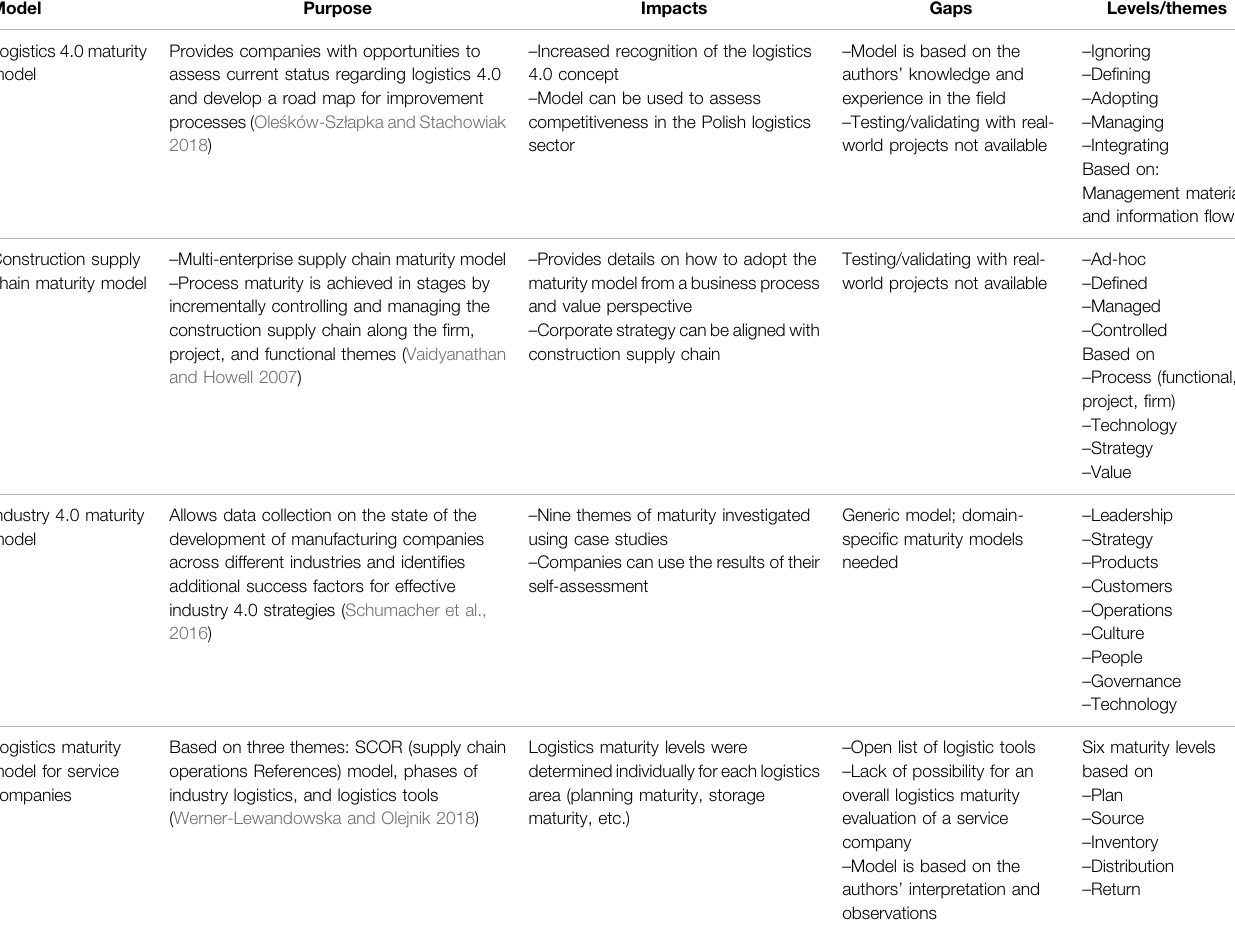
TABLE 2 | Previously developed maturity models for concepts relevant to construction logistics and their